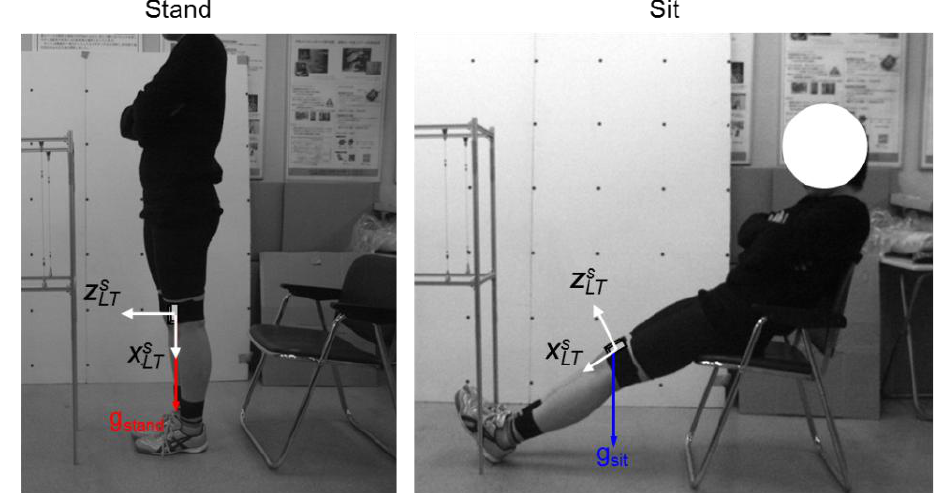
Figure 2. Sensor and global coordinate system calibration for LT. ( a ) Gravitational acceleration g and g are measured from acceleration sensors attached to a volunteer stand sit from two different postures. ( b ) The axes for the global coordinate system are defined as: Z the opposite direction of g , Y the cross product of g and g and X the cross product stand stand sit of Z and Y . ( c ) Sensor attachment location and gait wire frame model. The wire frame model is created by connecting characteristic positions of the lower limb. Sensor units are attached to seven body segments of the lower